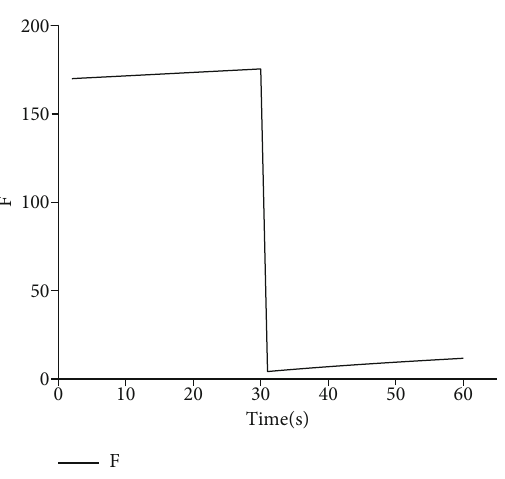
Figure 11: Time-strain curve diagram.